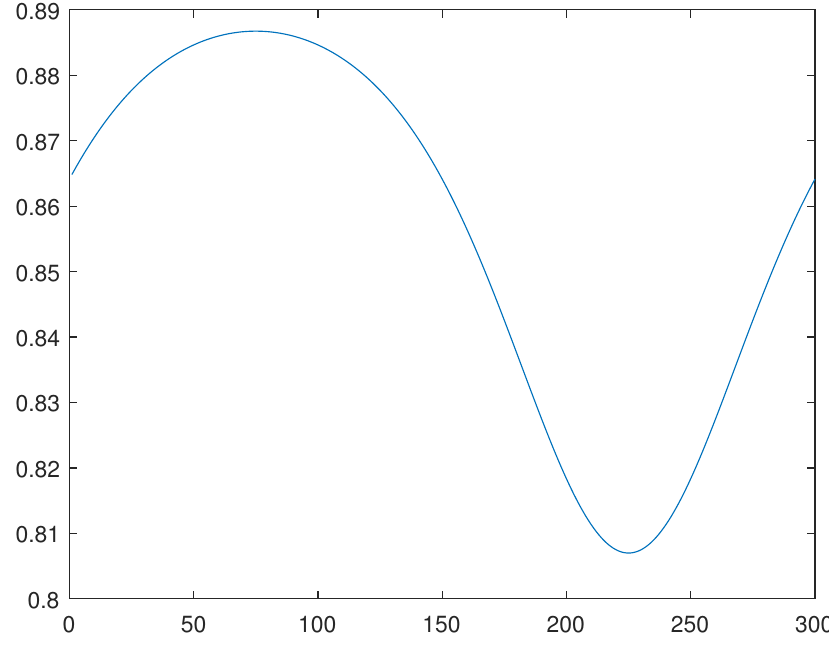
Figure 1. Line 2, solution u 2 ( x ) through the general method of lines.